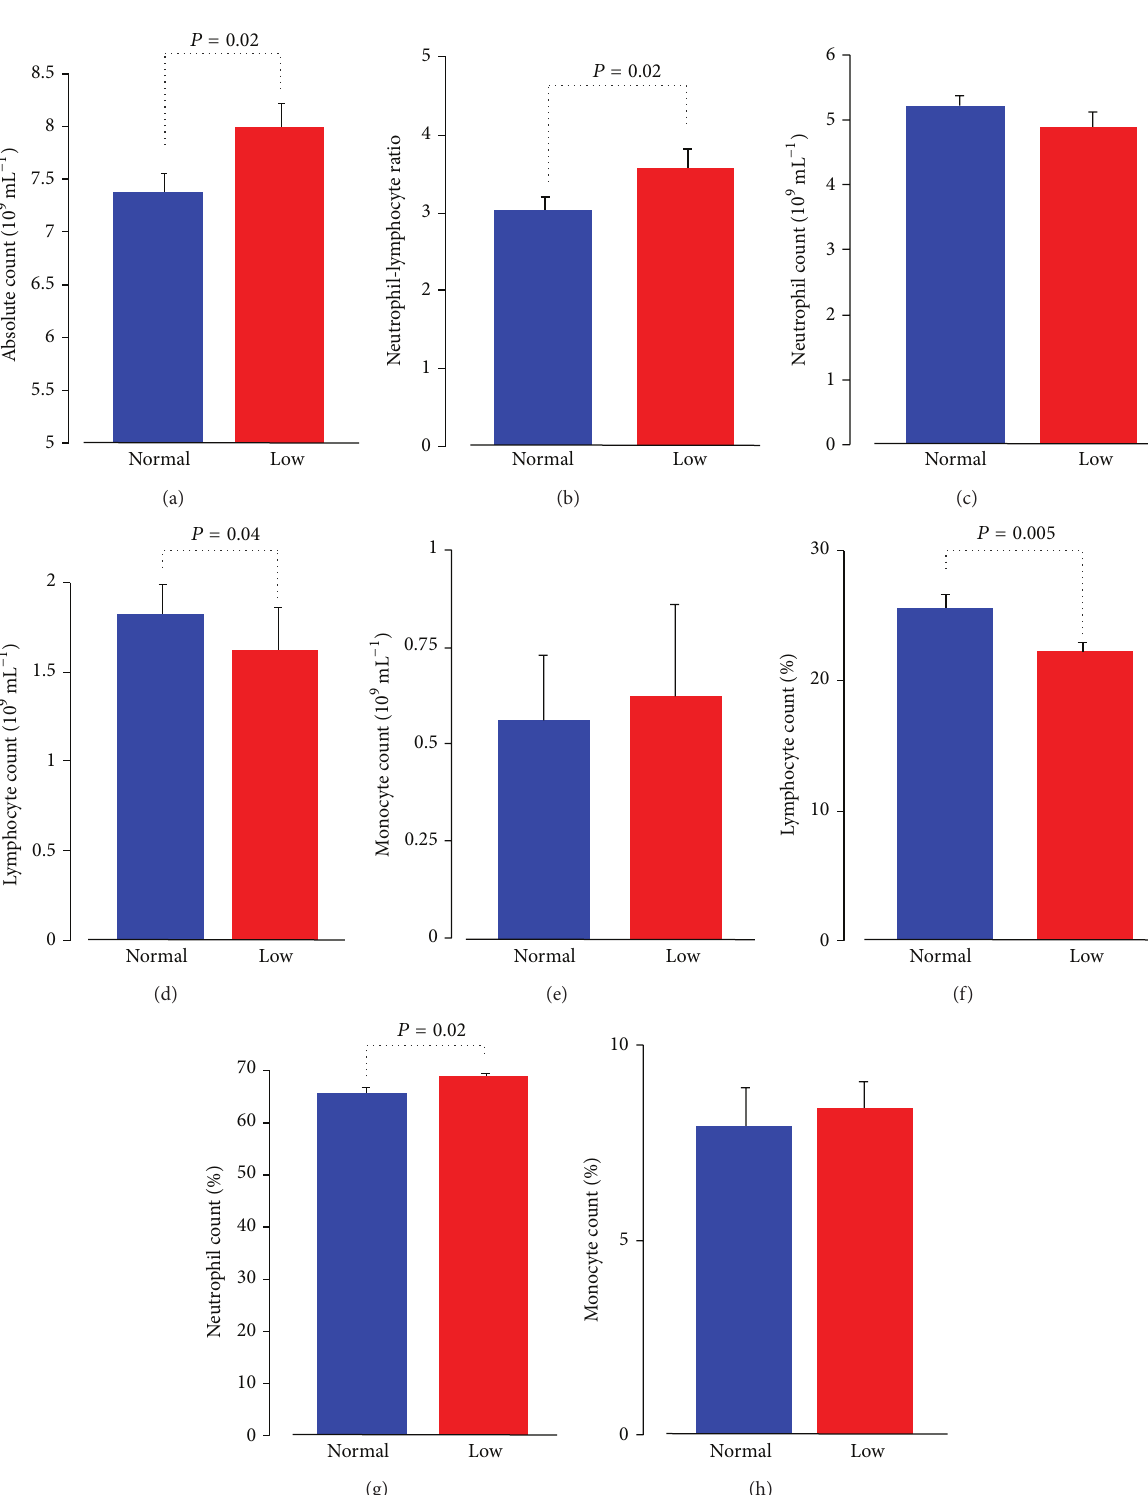
Figure 2: Leukocyte subsets according to AT value associated with poorer postoperative outcomes. (a) White cell count. (b) Neutrophil- lymphocyteratio.(c)Absoluteneutrophilcount.(d)Absolutelymphocytecount.(e)Absolutemonocytecount.(f)Proportionoflymphocytes. (g) Proportion of neutrophils. (h) Proportion of monocytes. All data are represented as mean ± SD; 𝑛 = 240